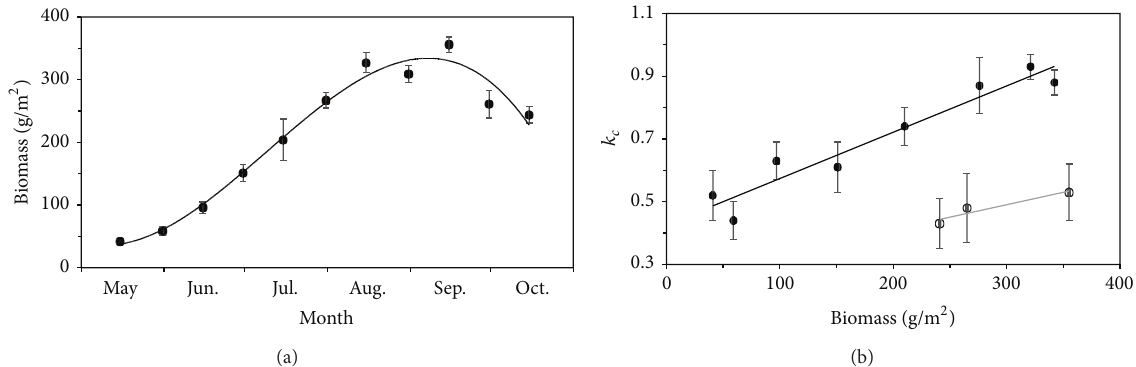
Figure 5: (a) The seasonal variation of biomass in this swamp meadow ecosystem in 2004 and (b) the response of 𝑘 𝑐 to biomass. The 𝑘 𝑐 was averaged with a bin width of 50 g/m 2 for biomass. Bars indicate mean ± SD.